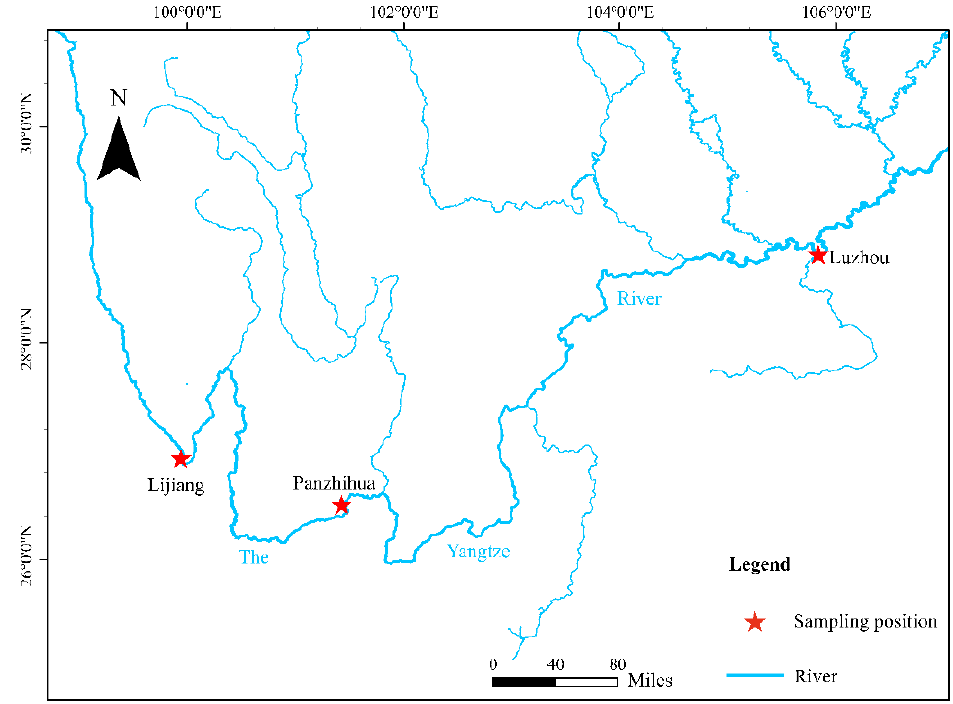
Figure 1. Sampling sites of Jinshaia sinensis in the upper reaches of the Yangtze River. Table 1. Genetic diversity indexes for all Jinshaia sinensis populations based on four genes. N: sample size; H: haplotypes numbers; h : haplotype (gene) diversity; Pi: nucleotide diversity; Tajima’s D: neutrality test